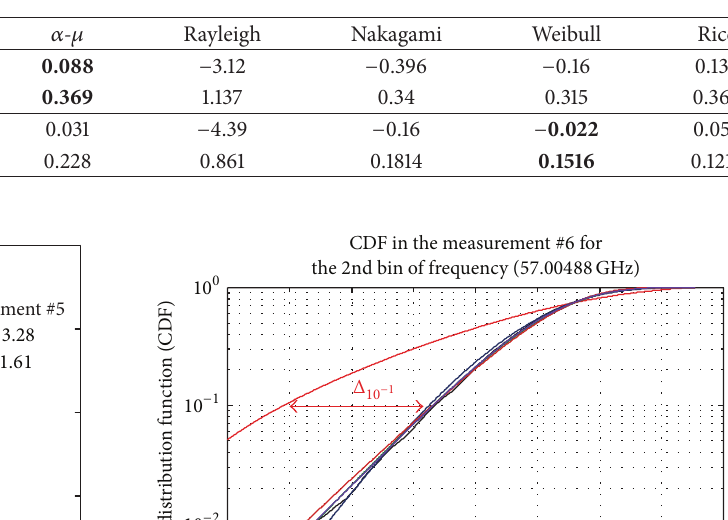
Table 6: Mean and standard deviation of the difference between the relative received power of the estimated CDFs and the relative received power of the experimental CDF for the same value of the CDF, 𝑝 = 10 − 1 , in the measurements #1 and #6.